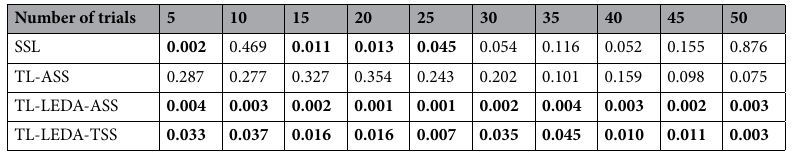
Table 3. Statistically significant difference in accuracy ( p values) between each pair of algorithms developed in Riemannian and Euclidean space respectively based on paired t-tests at 95% confidence level, at 10 numbers of training trials. Significant values are in